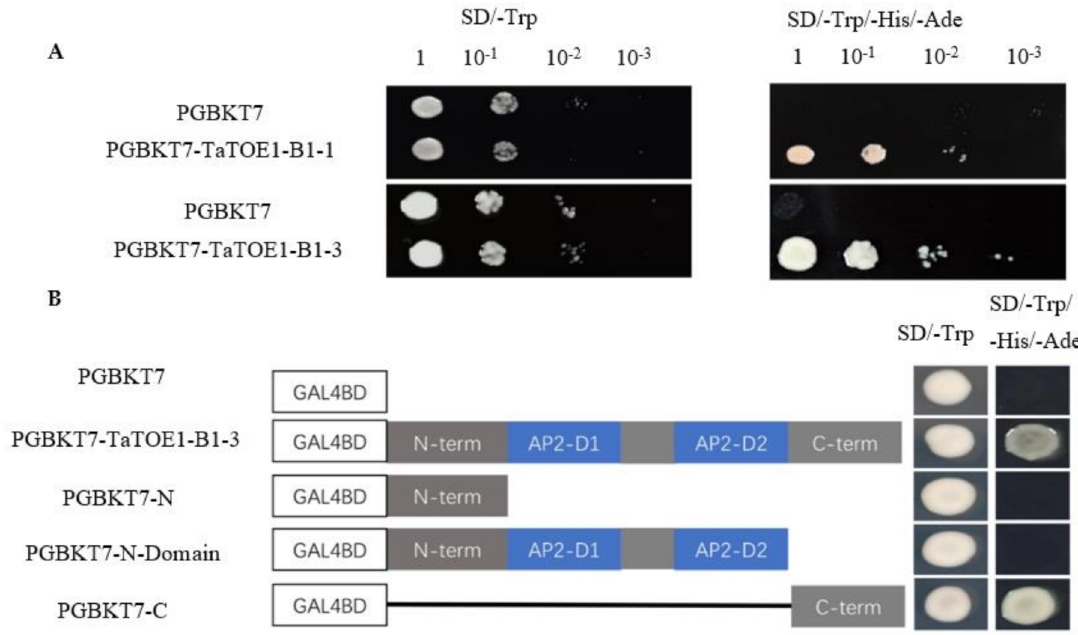
Figure 6. ( A ) Transcriptional activation activity analysis of TaTOE1-B1-1 and TaTOE1-B1-3; ( B ) Location analysis of transcriptional activation region of